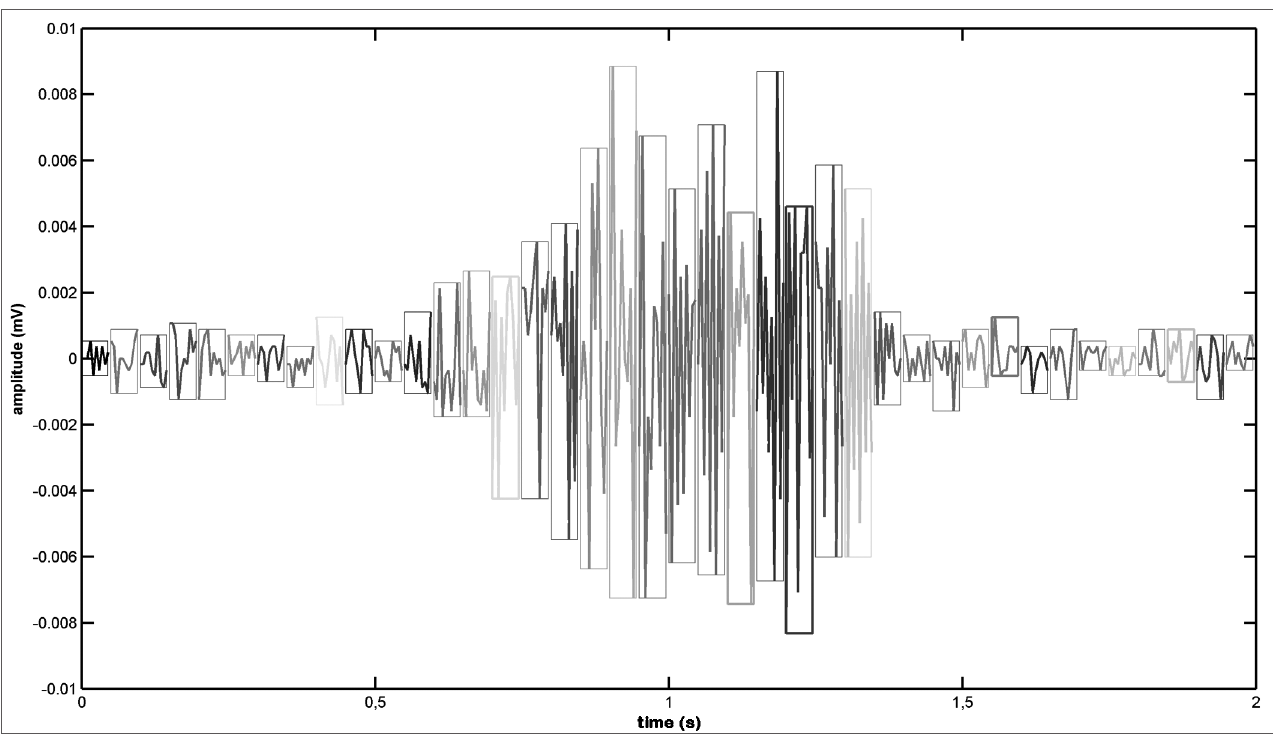
Figure 2. Sampled snoring signal - Sampled snoring signal (windows).